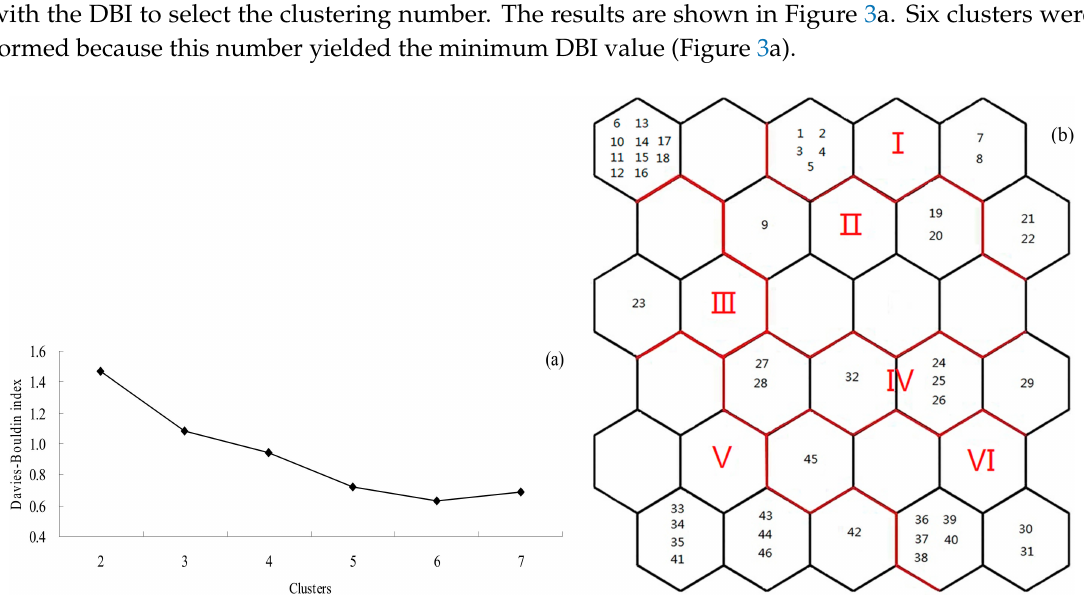
Figure 3. ( a ) Davies–Bouldin index (DBI) plot; ( b ) Results of the self-organizing map (SOM) clustering of the cells on the map plane (distribution of the sampling sites on the SOM according to the eight water quality parameters and clustering of the trained